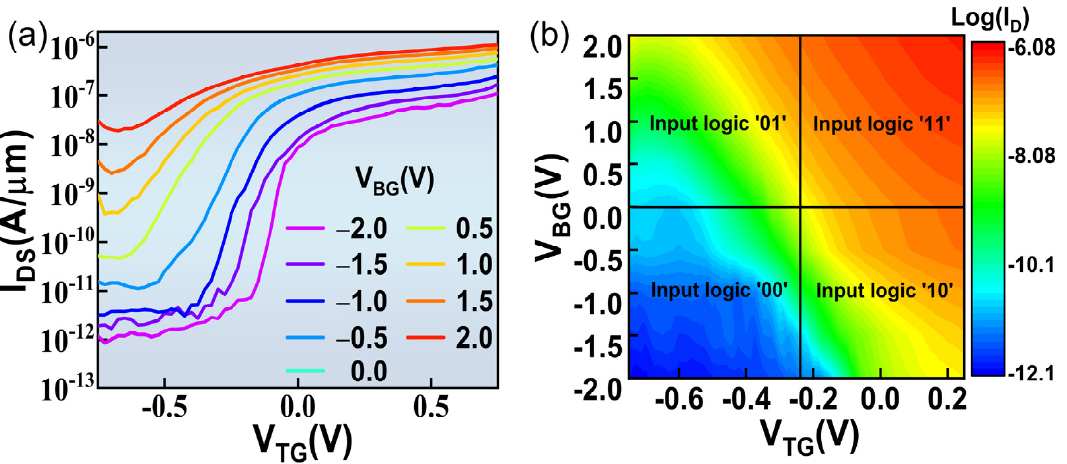
Figure 4. ( a ) The electric characteristic of CIPS/MoS 2 vdW in-situ OR-Logic operation; the inset shows the measurements configuration of the CIPS/MoS 2 vdW in-situ OR-Logic transistor. ( b ) The 2D mapping image of the output signals log(I DS ) as functions of the input signals V TG and V BG .